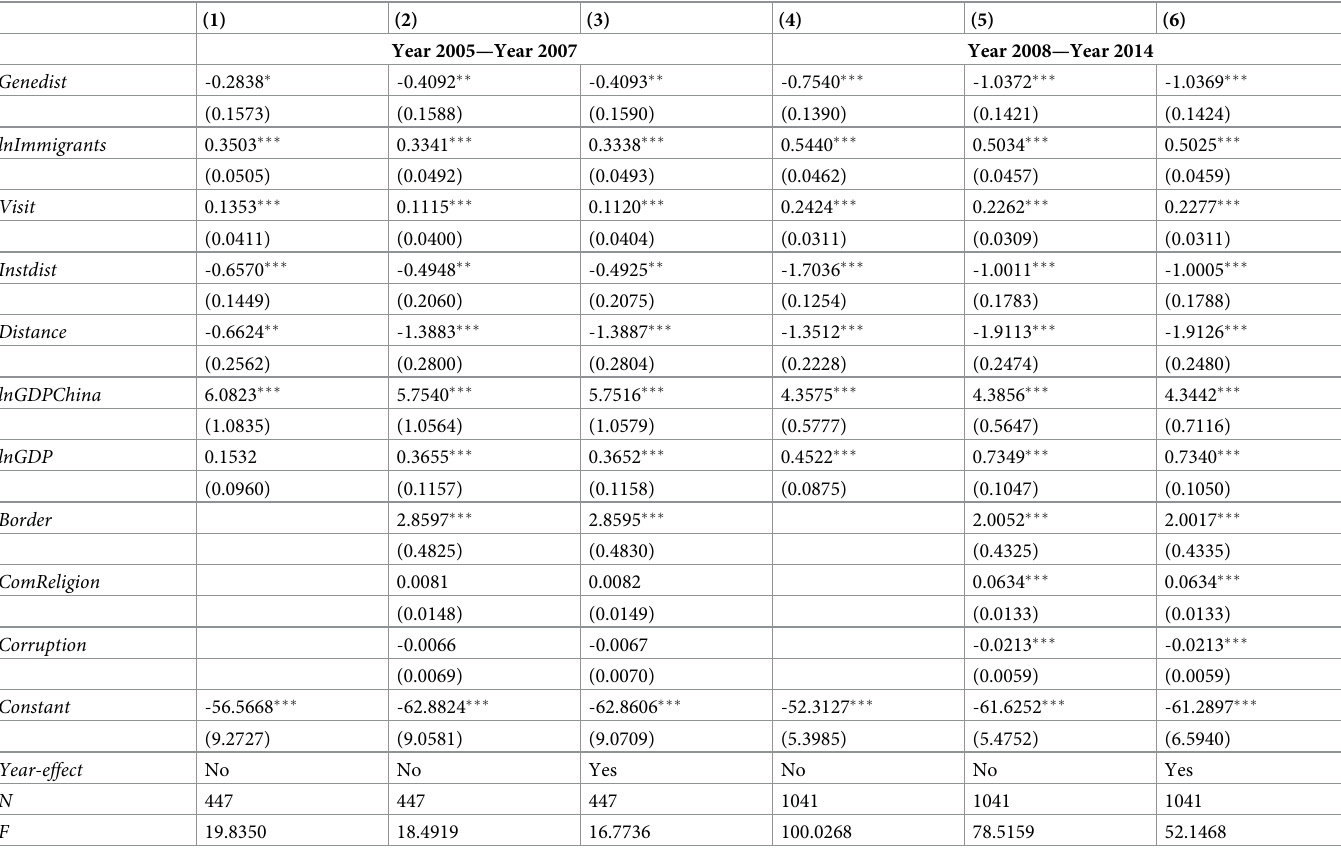
Table 7. The impact of “intimate” relations on China’s OFDI in energy sector: Considering the financial